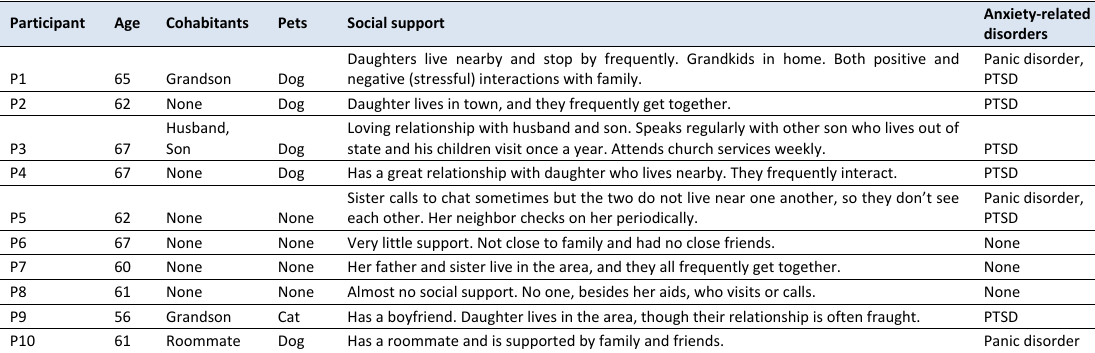
Table 1: Older adult participant